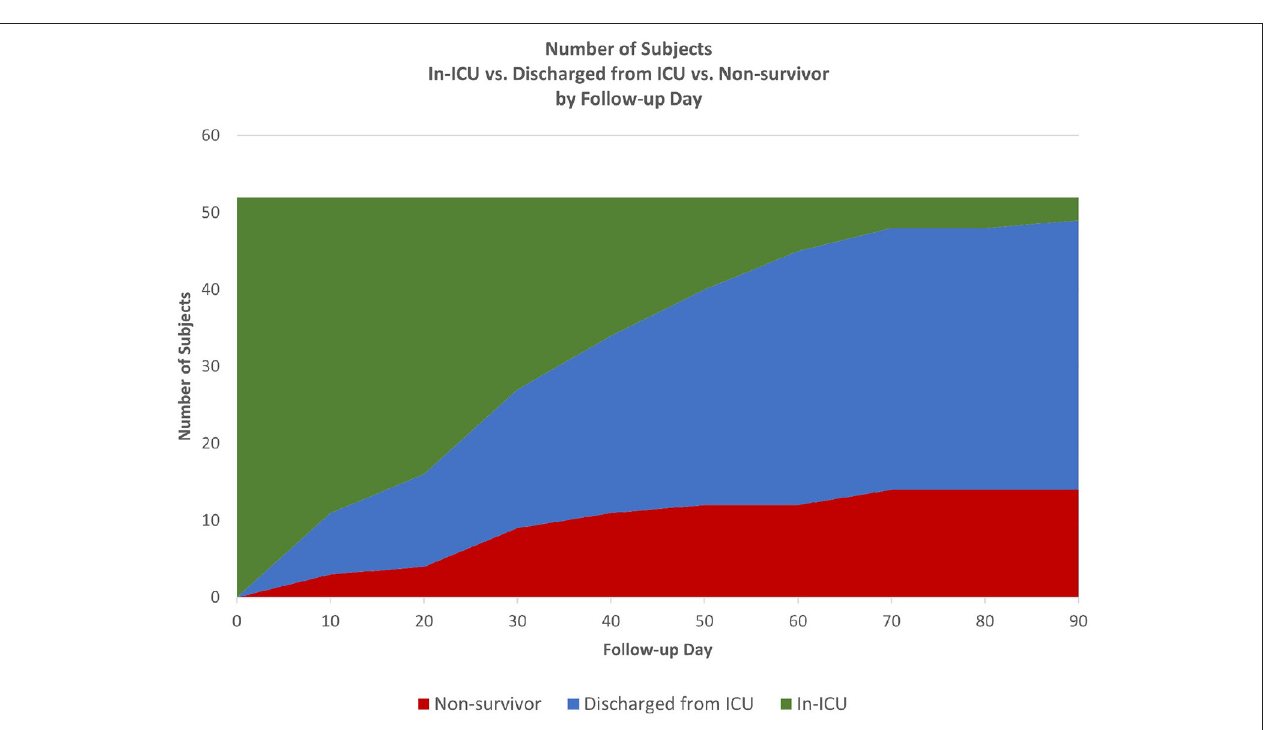
identify patients that may benefit from CytoSorb therapy, and the best method of application of this therapy with ECMO under the